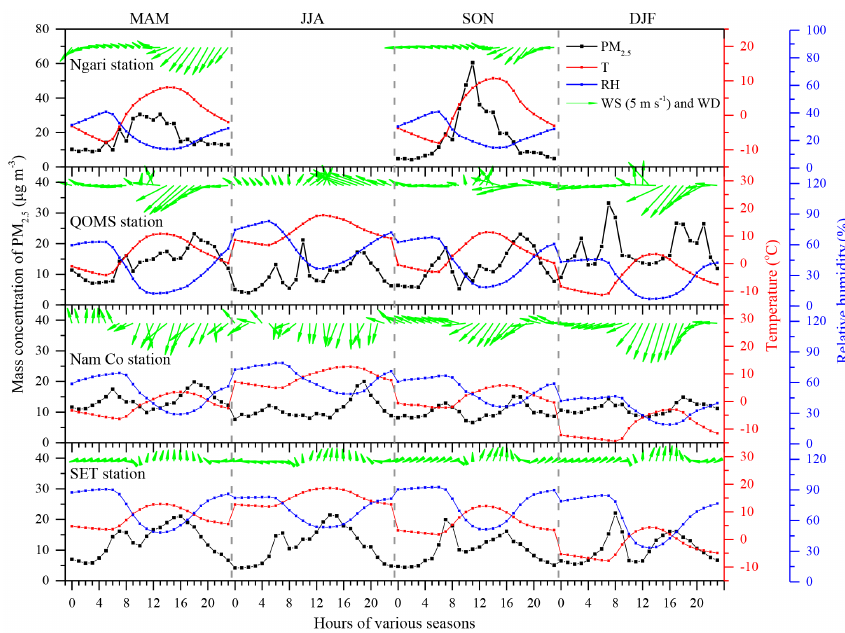
Figure 7. Seasonal diurnal variations in PM 2 . 5 concentrations, air T and RH over the 2011–2013 period at four background HTP sites (the Ngari station, the QOMS station, the Nam Co station and the SET station). The local time (LT) was used at each site according to longitudinal position.